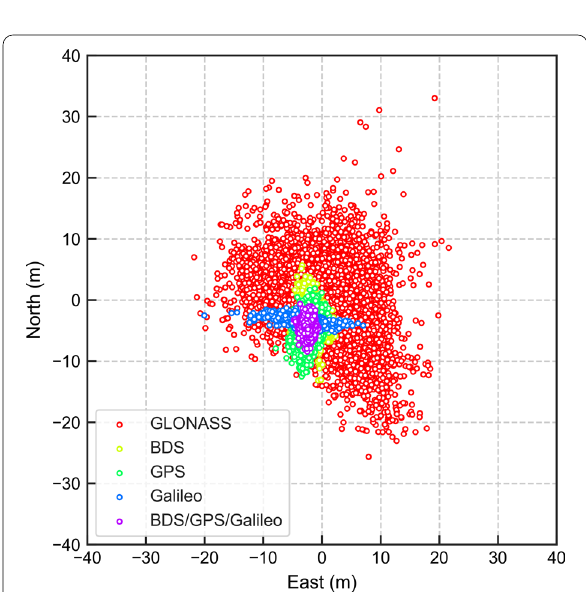
Fig. 15 Static smartphone positioning results based on different satellite systems and their combination